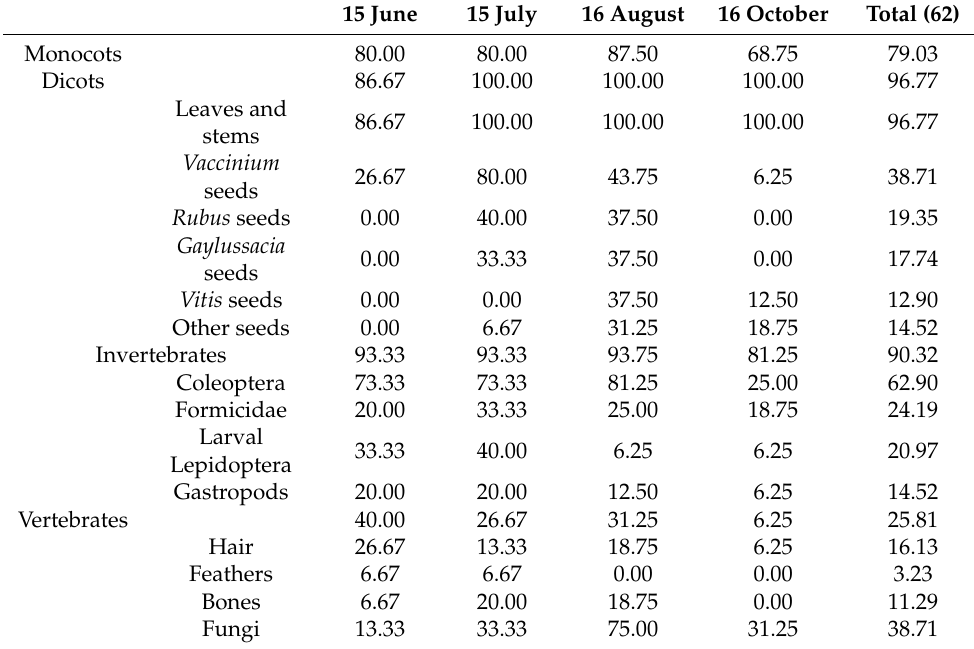
Table 1. Percent frequency of the occurrence of prey in diet categories detected in the feces of East-